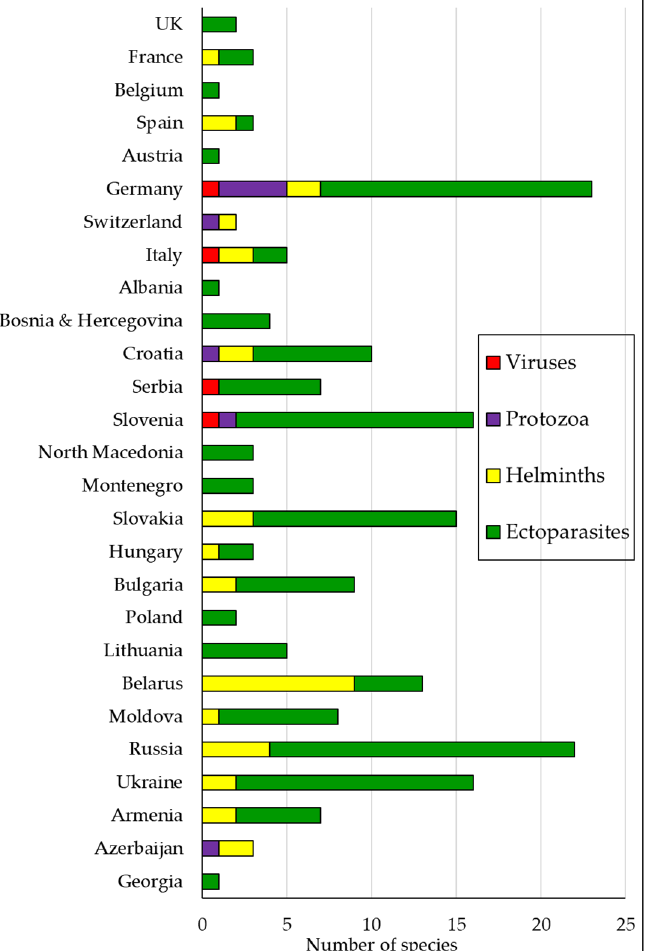
Figure 1. Number of species of parasites, bacteria and viruses found in Glis glis reflect different research efforts in various European countries.